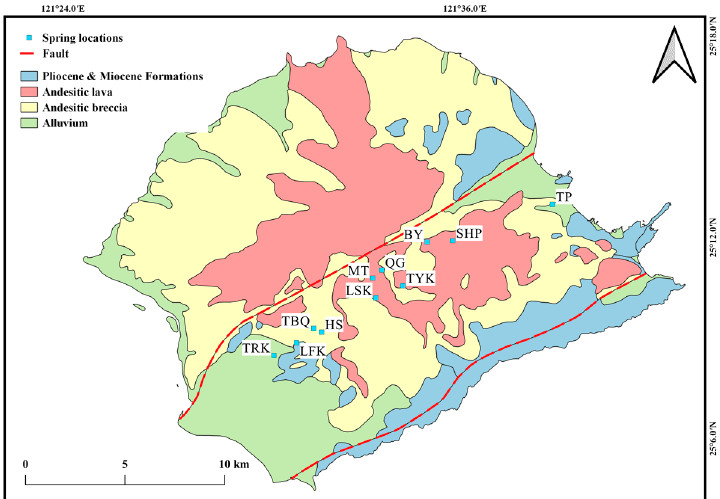
Figure 2. Simplified geological map of the Tatun Volcano Group.